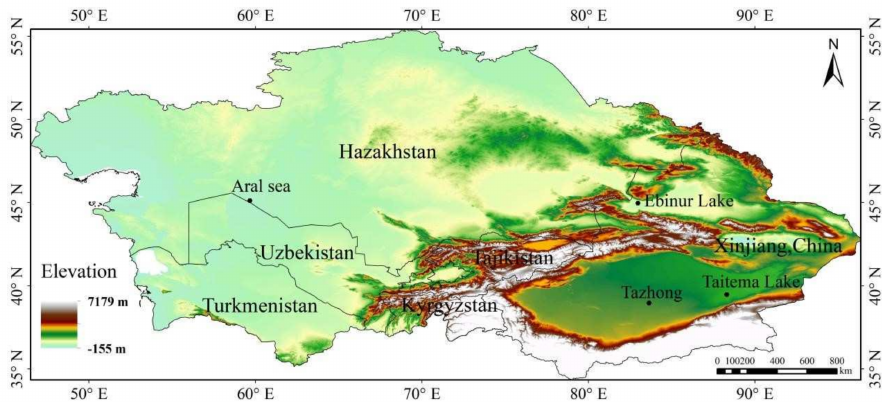
Figure 1. Study area of the five Central Asian countries and Xinjiang,